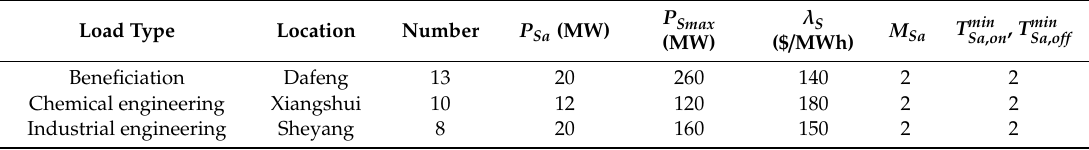
Table 3. Parameters of conventional units. Region